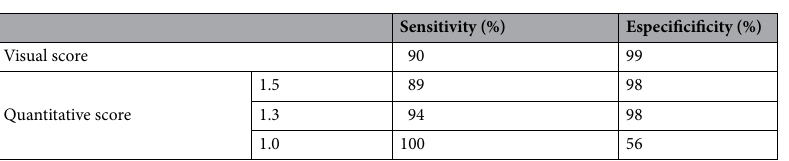
Table 2. Sensitivity and specificity for visual evaluation and quantitative evaluation using three threshold values (1.5, 1.3, and 1.0).